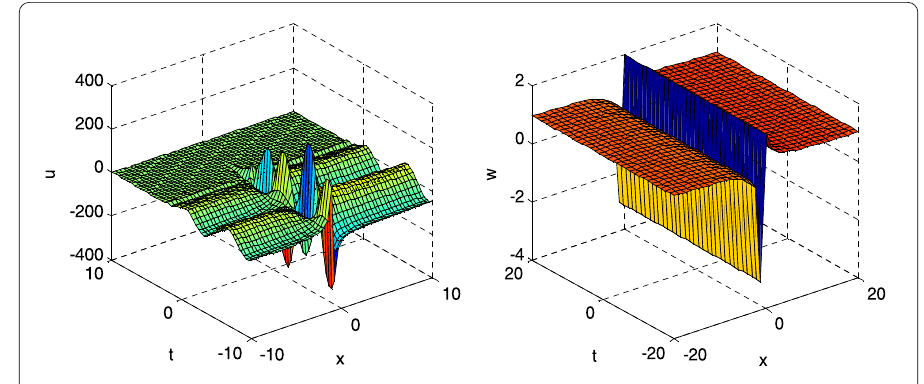
Figure 1 Oscillatory soliton solution (left) and dark soliton solution (right) given by equation (3.16) with A = 1, B = 1,